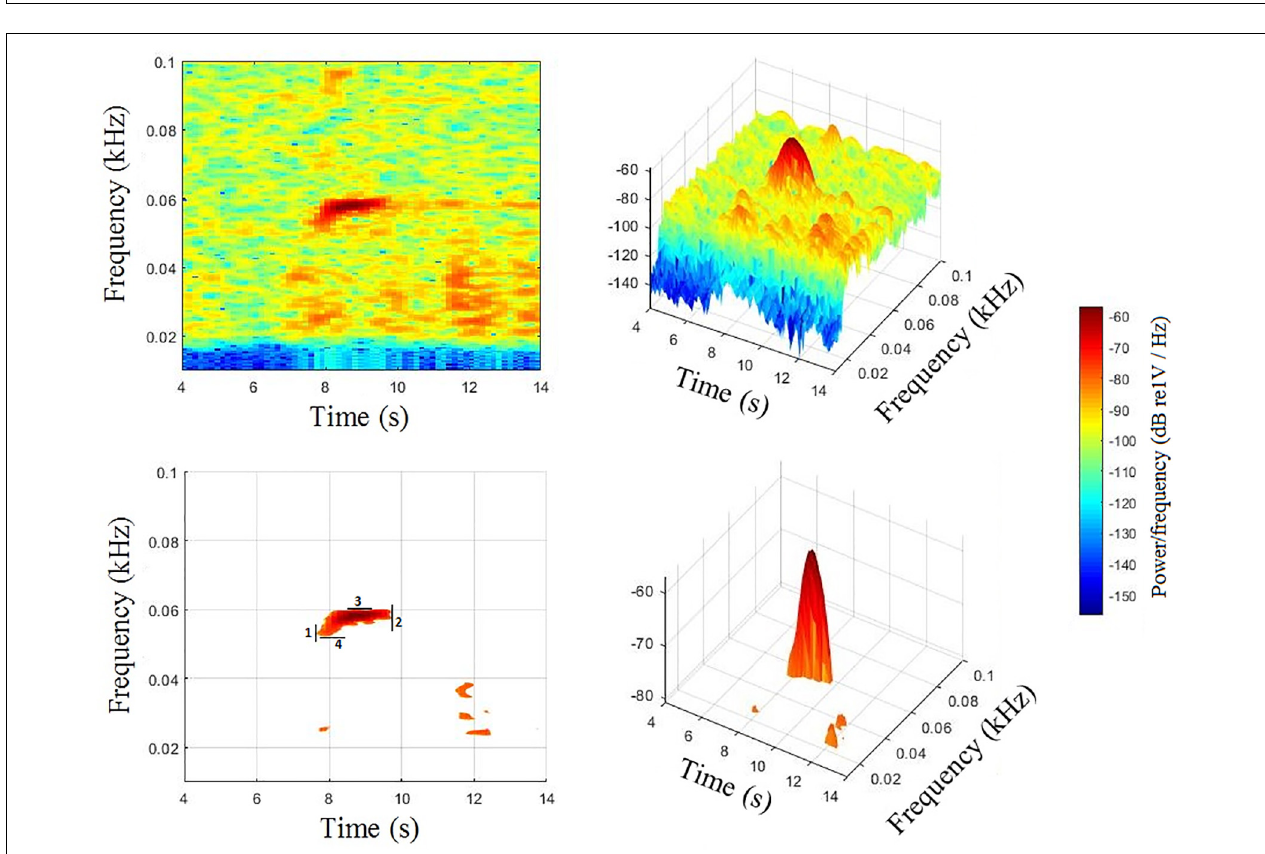
FIGURE 3 | Call example (type Be4) of Bryde’s whale from the Gulf of California, Mexico. Spectrogram 2D (top left) , spectrogram 3D (top right) , spectrogram 3D threshold at 24 dB from the maximum amplitude value (bottom right) , and spectrogram 2D threshold at 24 dB from the maximum amplitude value (bottom left) showing the clear limits of the call: start (1), end (2), maximum (3), and minimum (4). Spectrogram: Butterworth (2nd order) high-pass filter at 40 Hz cut off, Hamming window size 2048, 85% overlap, and a frame of